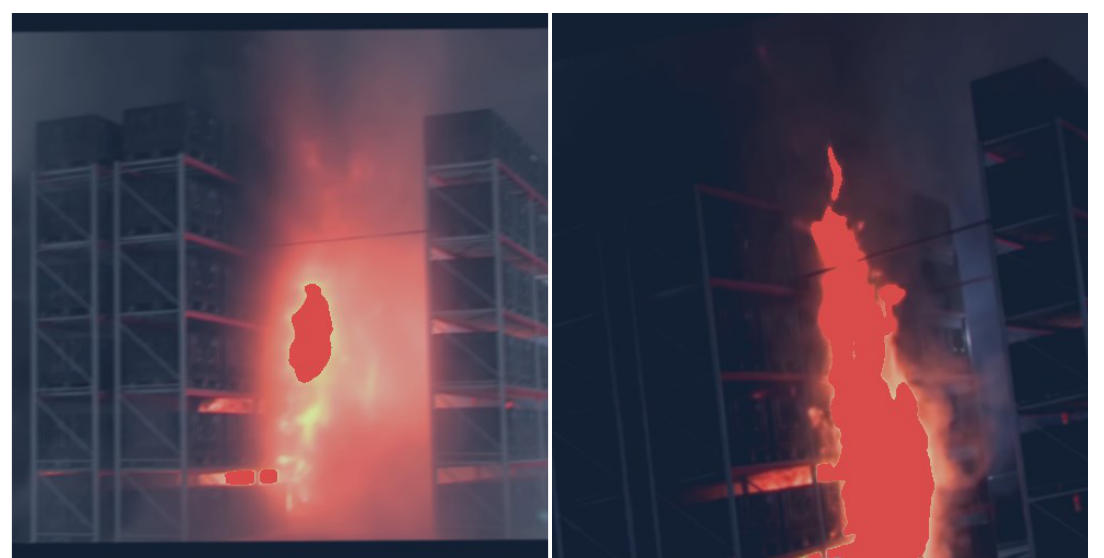
Figure 9. Examples of image segmentation.